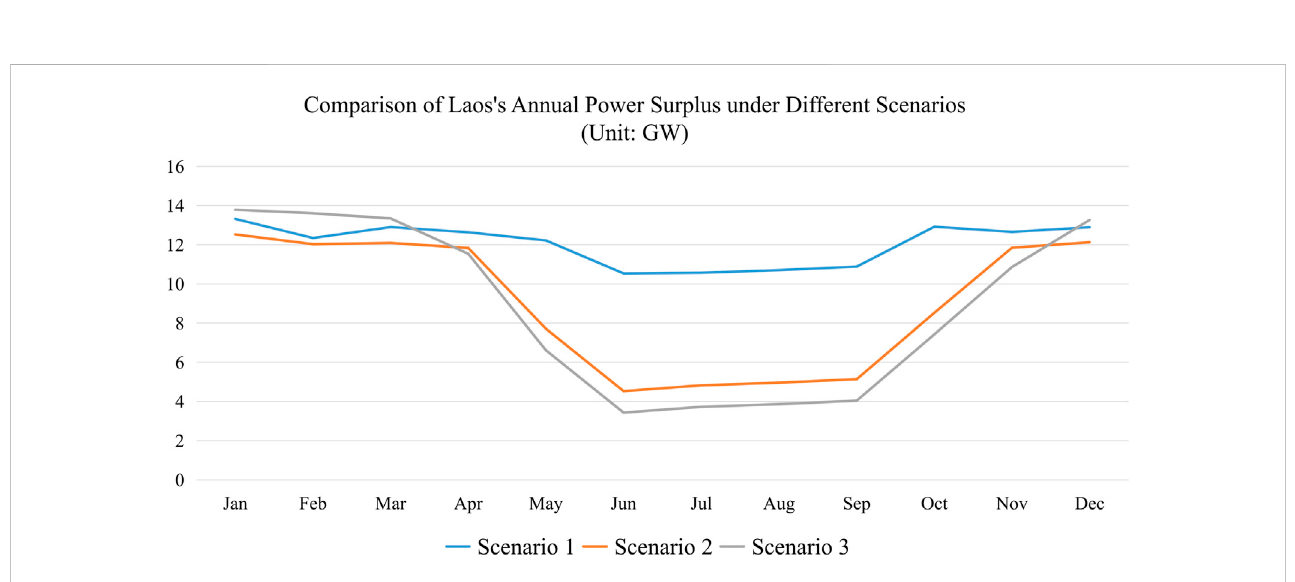
FIGURE 8 Comparison of Lao ’ s annual power surplus under different